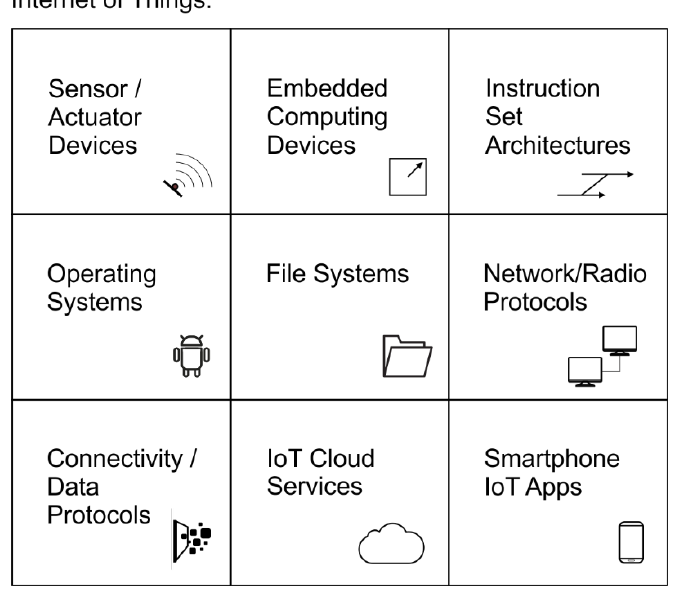
Figure 1. Various components of Internet of Things.